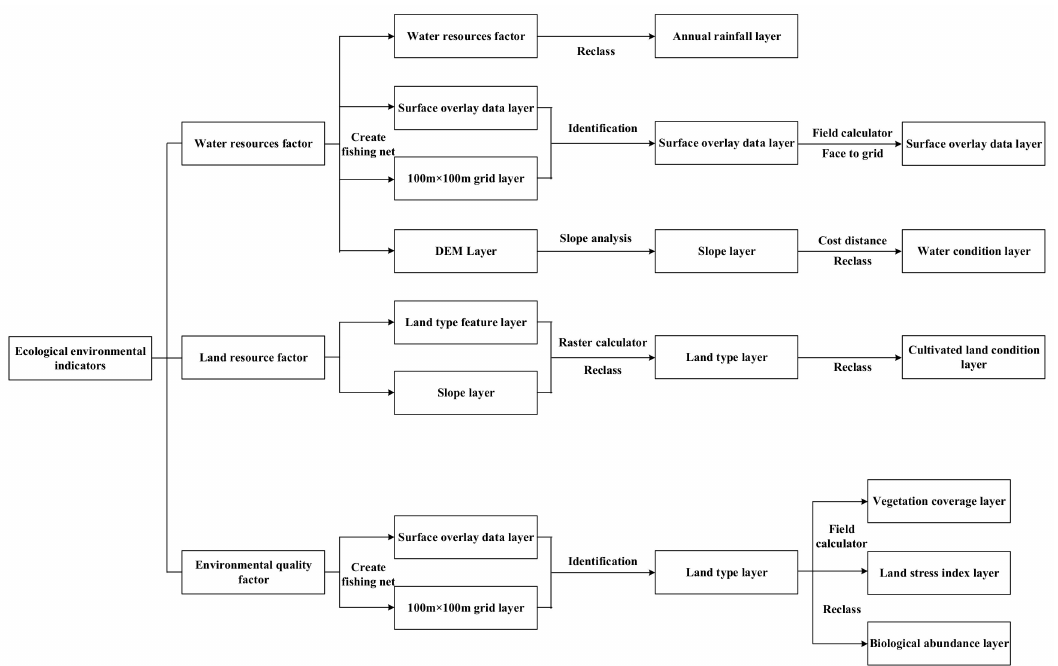
Figure 4. Processing flow chart of eco-environment